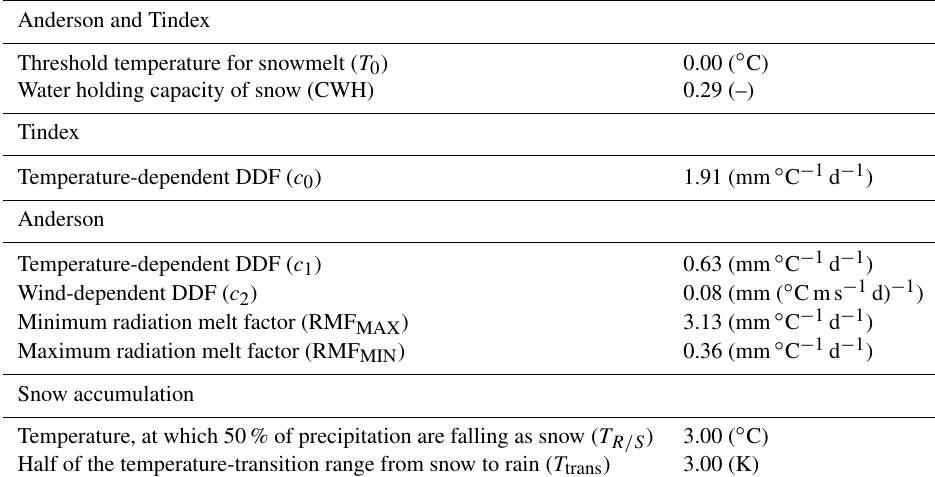
Table 1. Parameters of the two snowmelt routines as determined by the calibration routine. T 0 and CWH are mutual parameters of both models. The snow accumulation parameters are based on the findings of Auer